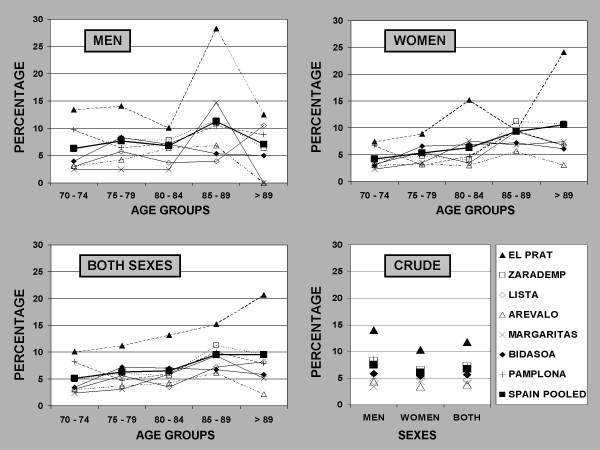
Crude and age-specific prevalence of stroke in Spanish populations.